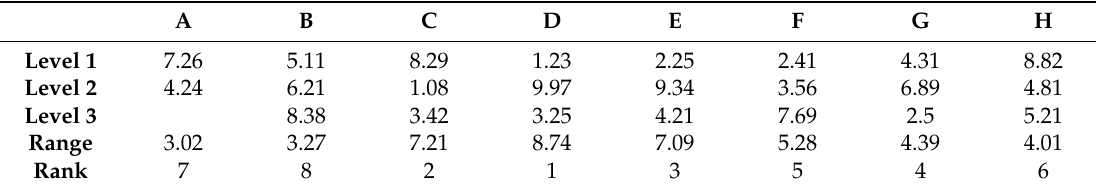
Table 4. Factor response table of the signal/noise (SN)